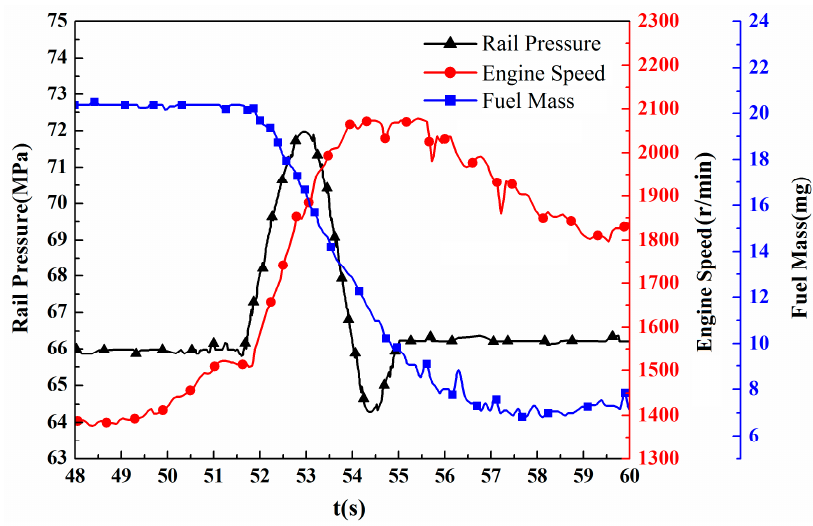
Figure 17. Rail pressure, engine speed and fuel mass vs. time on the experimental prototype.